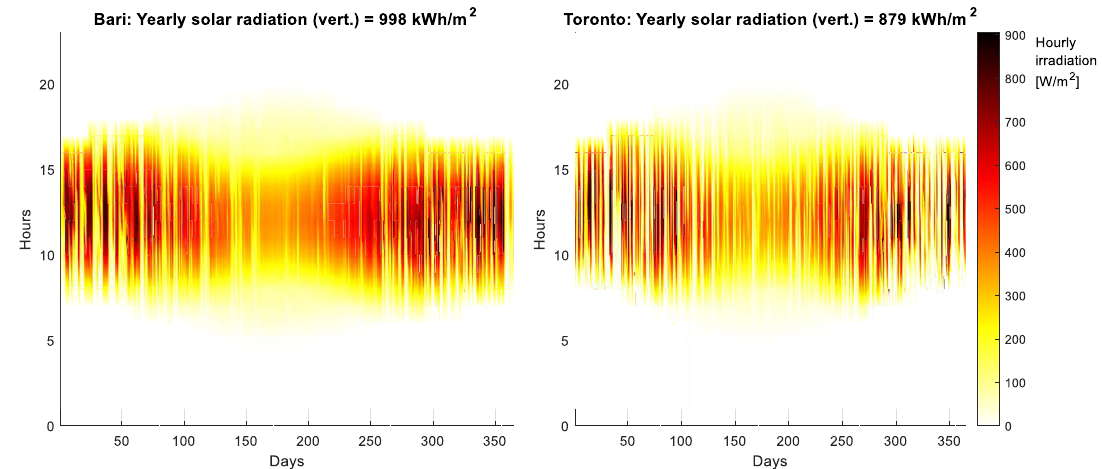
Figure 4. Solar radiation available on vertical planes, in Bari and Toronto. 209